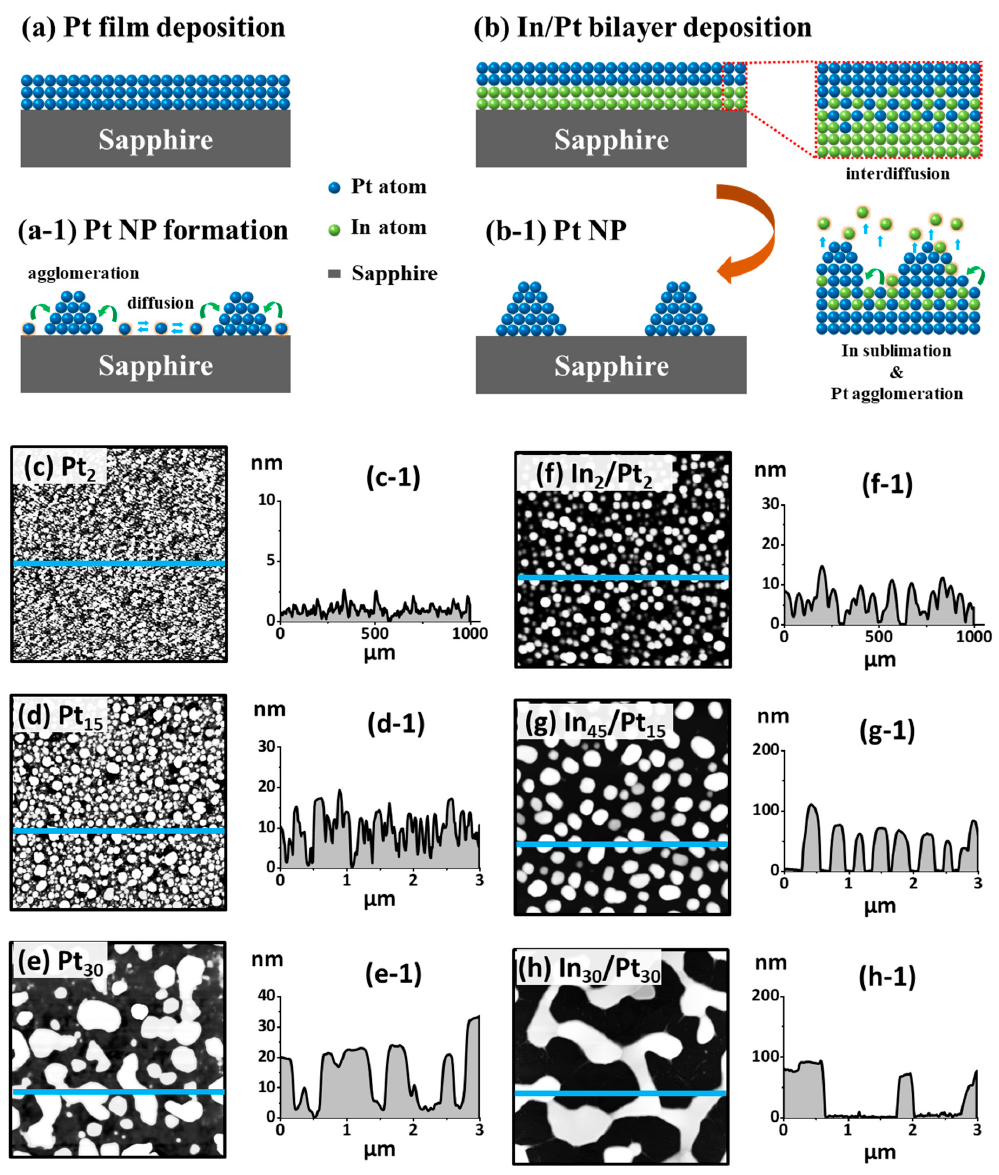
Figure 1. Comparison of the conventional solid state dewetting (SSD) and modified SSD of Pt film and In / Pt bilayer on sapphire. ( a )–( a-1 ) Schematic of Pt nanoparticles (NPs) formation by the annealing of pure Pt thin film: i.e., conventional SSD. ( b )–( b-1 ) Scheme of improved Pt NP fabrication with the In / Pt bilayer films: i.e., modified SSD. ( c )–( e ) AFM images of the Pt NPs fabricated with 2, 15 and 30 nm thick Pt films at 900 ◦ C for 450 s. ( c-1 )–( e-1 ) Cross-sectional line profiles of Pt NPs in ( c )–( e ). ( f )–( h ) AFM images of the Pt NPs fabricated with the In 2 nm / Pt 2 nm , In 30 nm / Pt 30 nm , and In 45 nm / Pt 15 nm bilayers at 900 ◦ C for 450 s. ( f-1 )–( h-1 ) Cross-sectional line profiles of Pt NPs in ( f )–( h